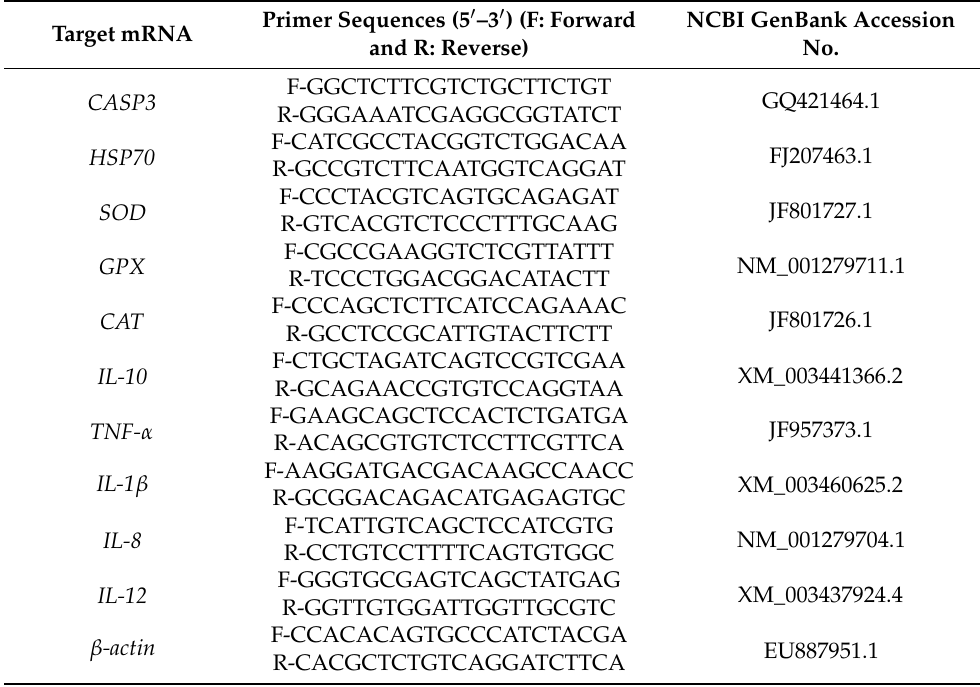
Table 1. Primers sequences for the target genes used for SYBR green real-time PCR (RT-PCR). Target